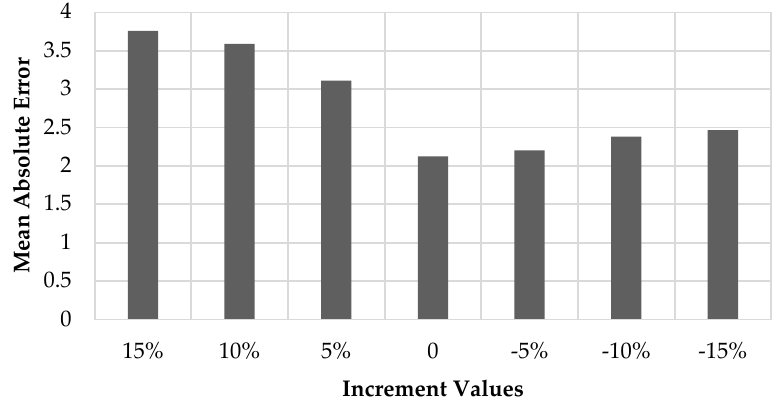
Figure 6. MAE results of different values of condition incrementation as compared to the base dataset with 0% incrementation.